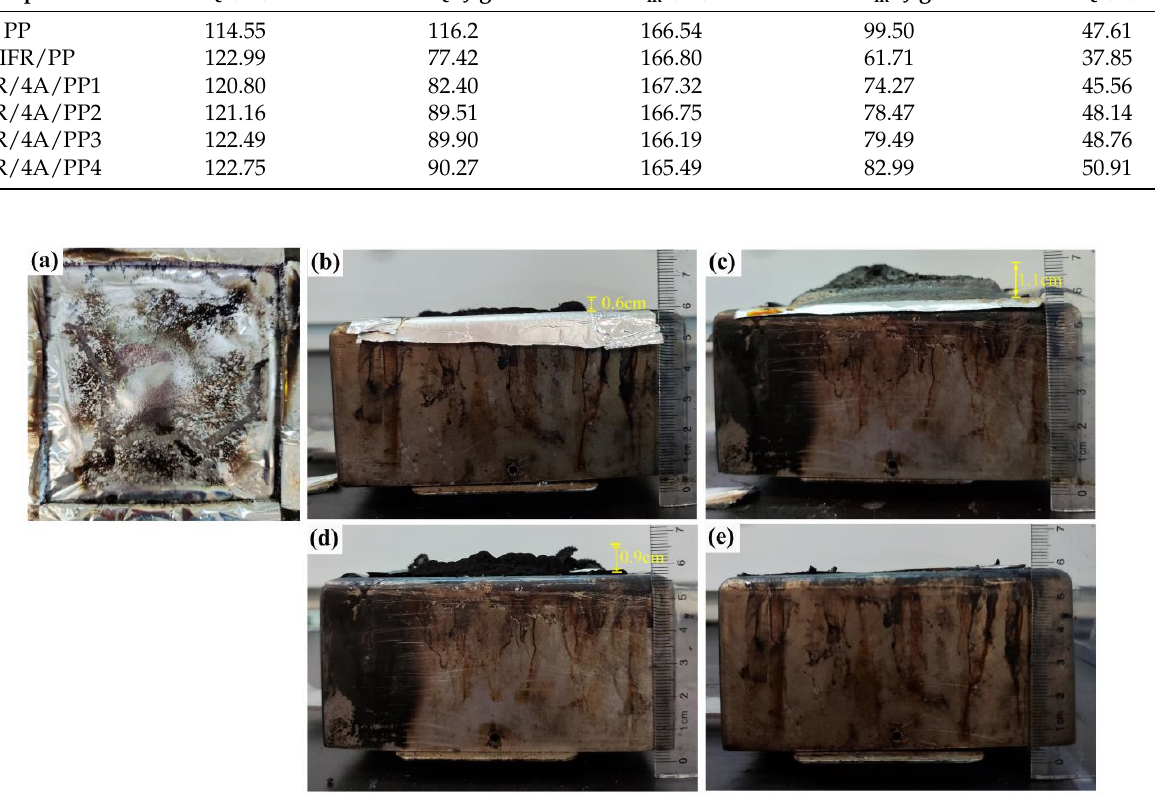
Figure 7. The digital photos of carbon residue for pure PP ( a ), TH-IFR/PP ( b ), TH-IFR/4A/PP1 ( c ),